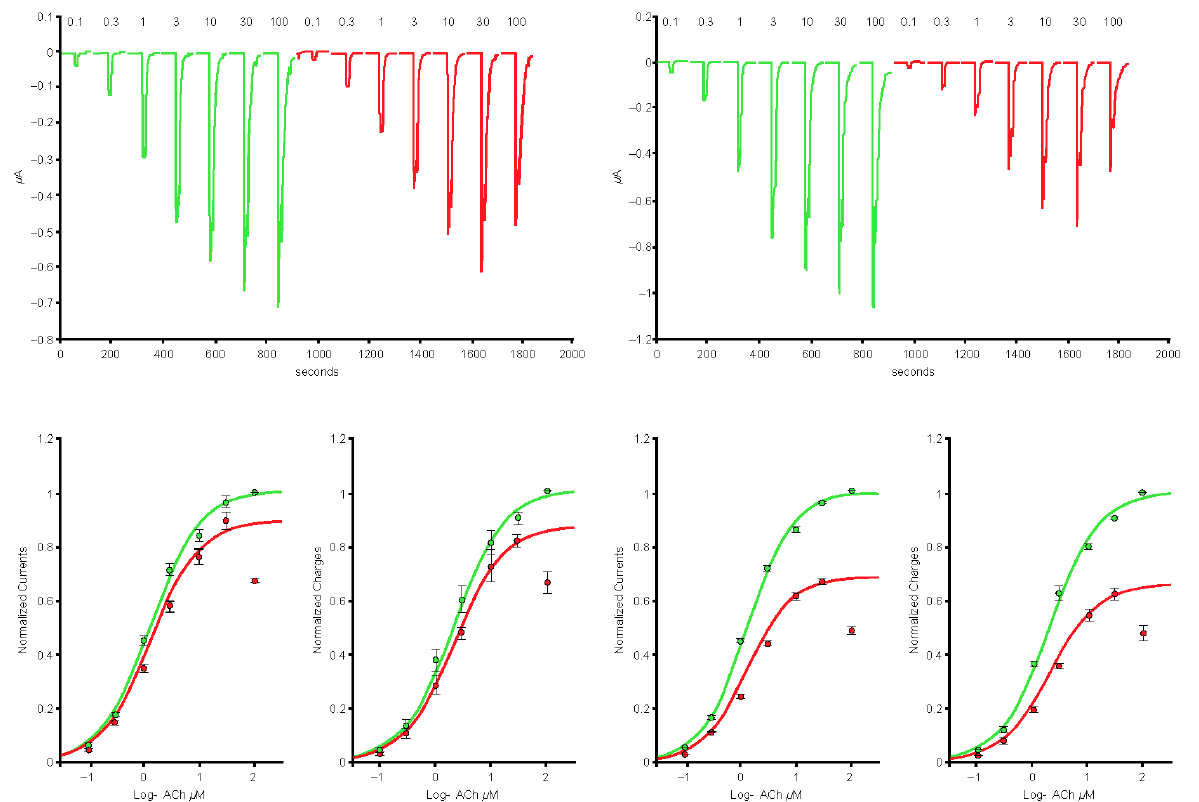
Figure 1. Effects of the spike protein containing the receptor-binding domain (Spike-RBD) protein at the concentration-response curve to acetylcholine (ACh) of the α 4 β 2 nicotinic acetylcholine receptor. Typical currents were recorded in the same cell before (green traces) and during short (left-hand side) and long (right-hand side) exposure to 1 µ g/mL of the Spike-RBD protein (red traces). Currents were elicited by brief exposure to ACh test pulses with a series of concentrations. Currents were normalized to unity vs. the maximal value and average results obtained in seven cells were plotted vs. the logarithm (log) of the ACh concentration. The green curve is the best fit obtained with the Hill equation. Areas under the curve are plotted on the lower right-hand side.